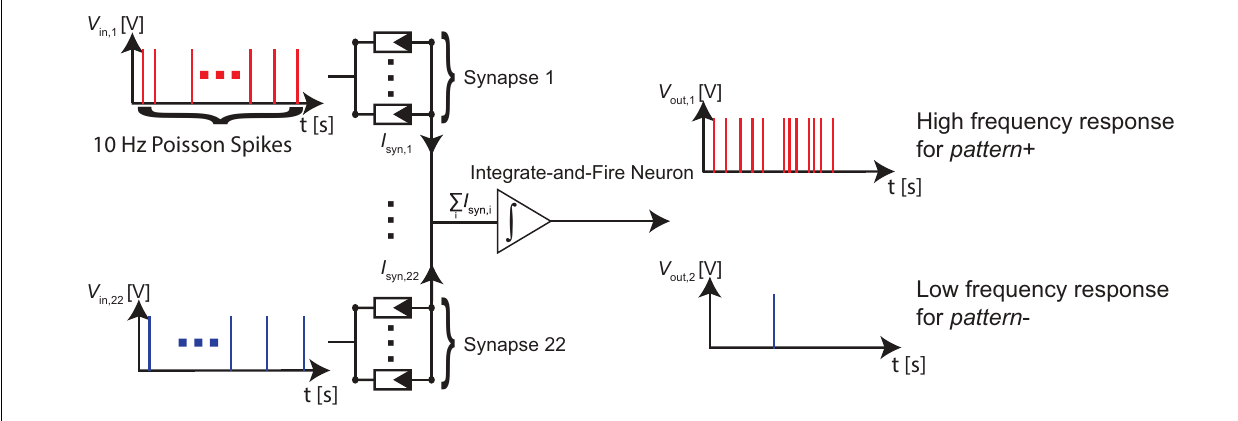
FIGURE 2 | The neural network consists of 22 synapses connected to an integrate-and-fire type output neuron. The synapses consist of multiple VCM ReRAM devices connected in parallel. The studied range is between 1 and 24 cells per synapse. It is trained to react to a pattern+ (which is presented to 11 of its synapses) with a high number of spikes and to a pattern- (which is also presented to 11 of its synapses) with a low number of spikes.